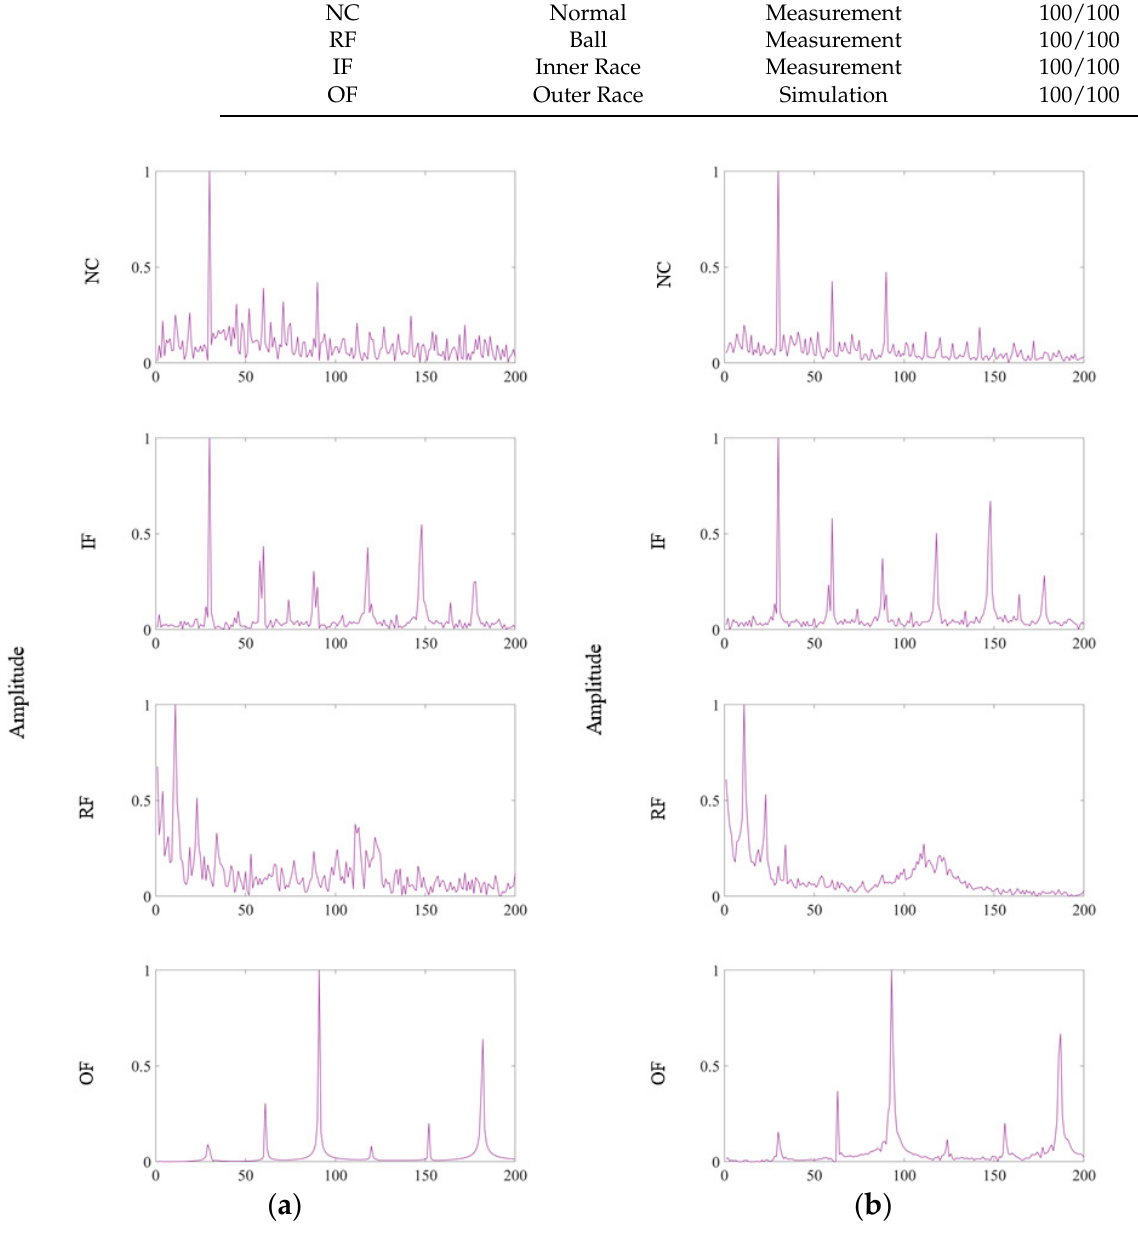
Figure 8. Comparison between raw and generated signals for bearings: ( a ) Raw signals, ( b ) Gener- ated signals.